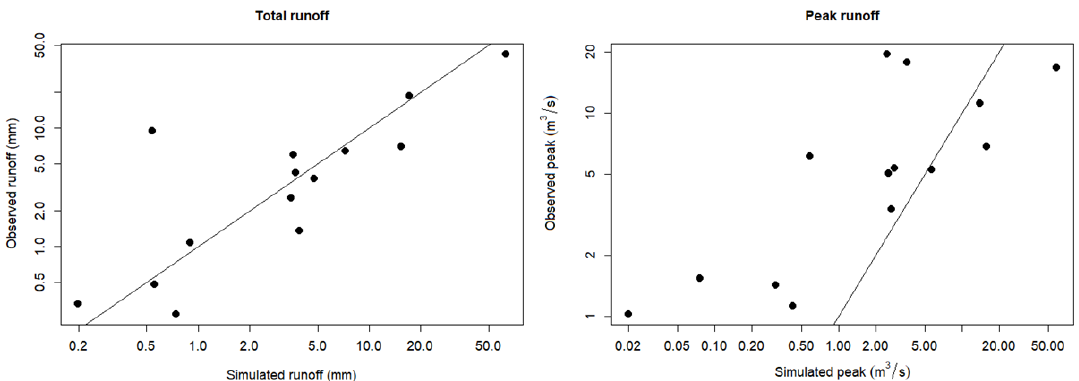
Figure 6. Rainfall-runoff relationship for all observed storm events, with several SCS CN rainfall- runoff relationships, in non-log (top) and log-log (bottom). Taken from Biggs et al. [33].